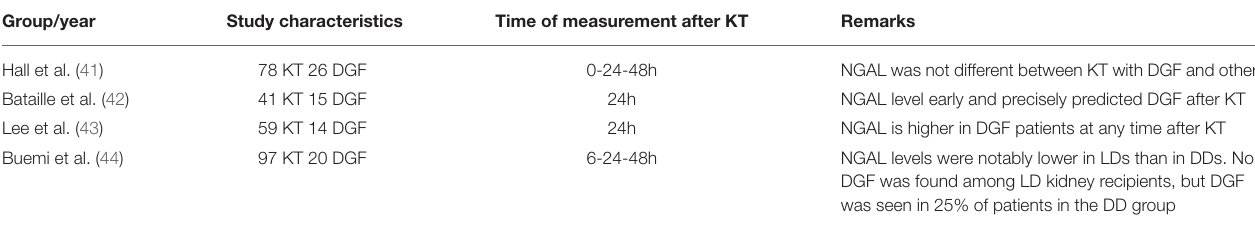
TABLE 2 | Comparison of studies on serum NGAL for the diagnosis of DGF after kidney transplantation.